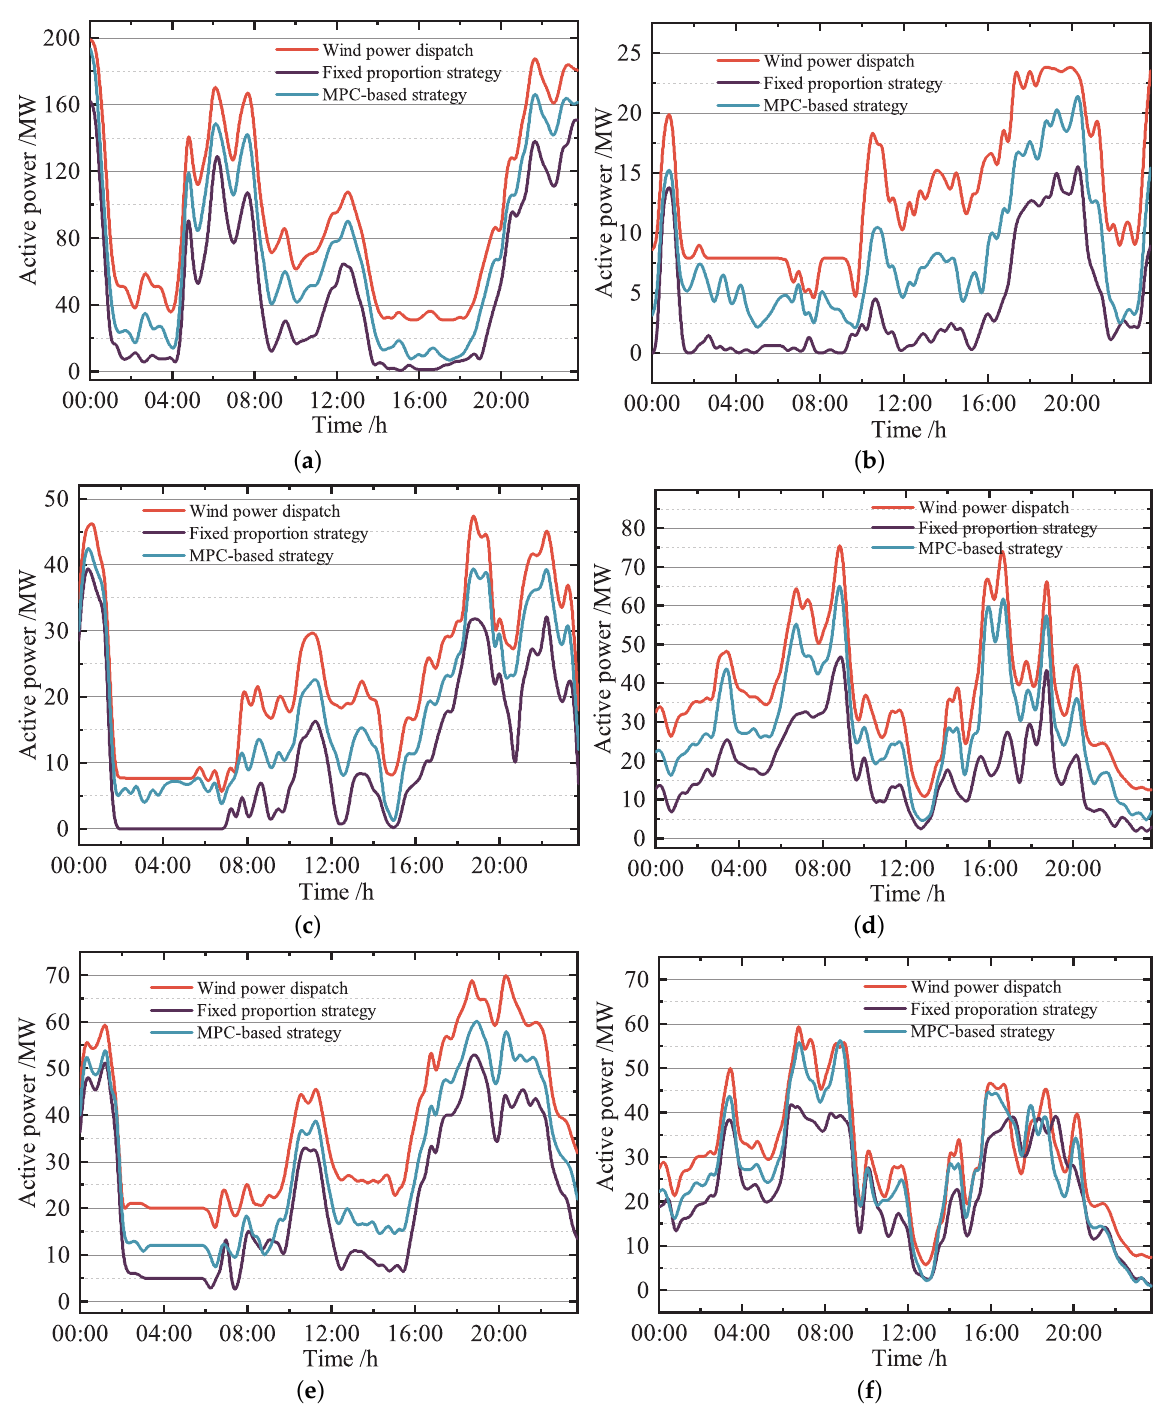
Figure 11. Control results of the active power stratification predictive control approach in a wind farm. ( a ) WF1; ( b ) WF2; ( c ) WF3; ( d ) WF4; ( e ) WF5; ( f ) WF6. Under hierarchical predictive control, the wind farm output is optimized based on three links of predictive model control to track the grid dispatch plan values as the spatial and temporal scales are refined layer by layer. The accuracy of the tracking and dispatching plan is subsequently improved. For example, the WF4 output curve can effectively track the dispatch curve from 15:00 to 18:00. The error caused by the control effect is improved by the prediction information under the temporal scales, and the reasonable distribution of the wind farm output is